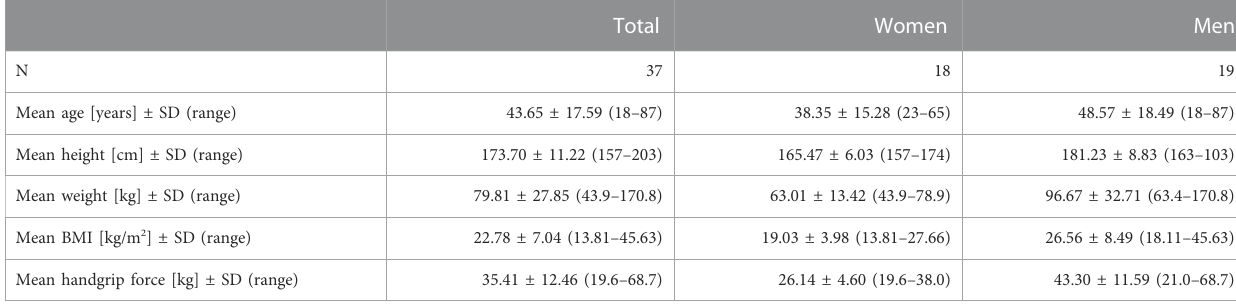
TABLE 2 Participant characteristics.